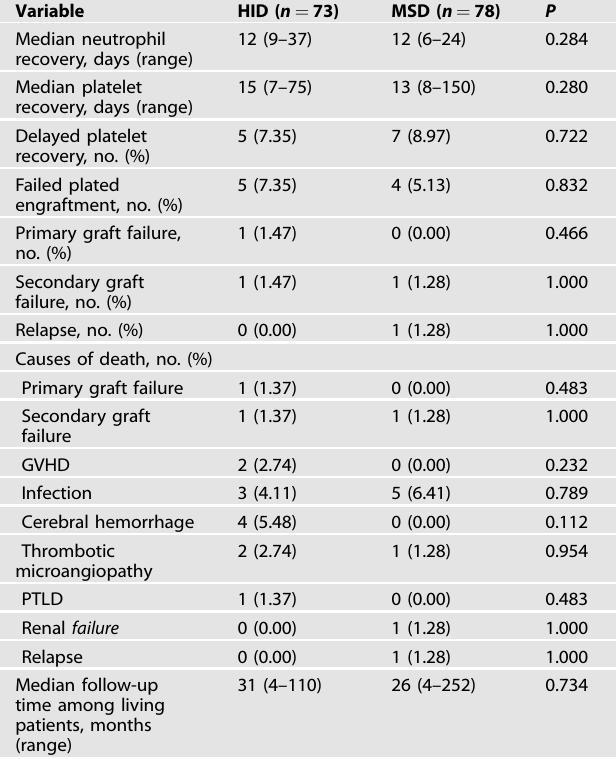
Table 1. Characteristics of PNH patients and